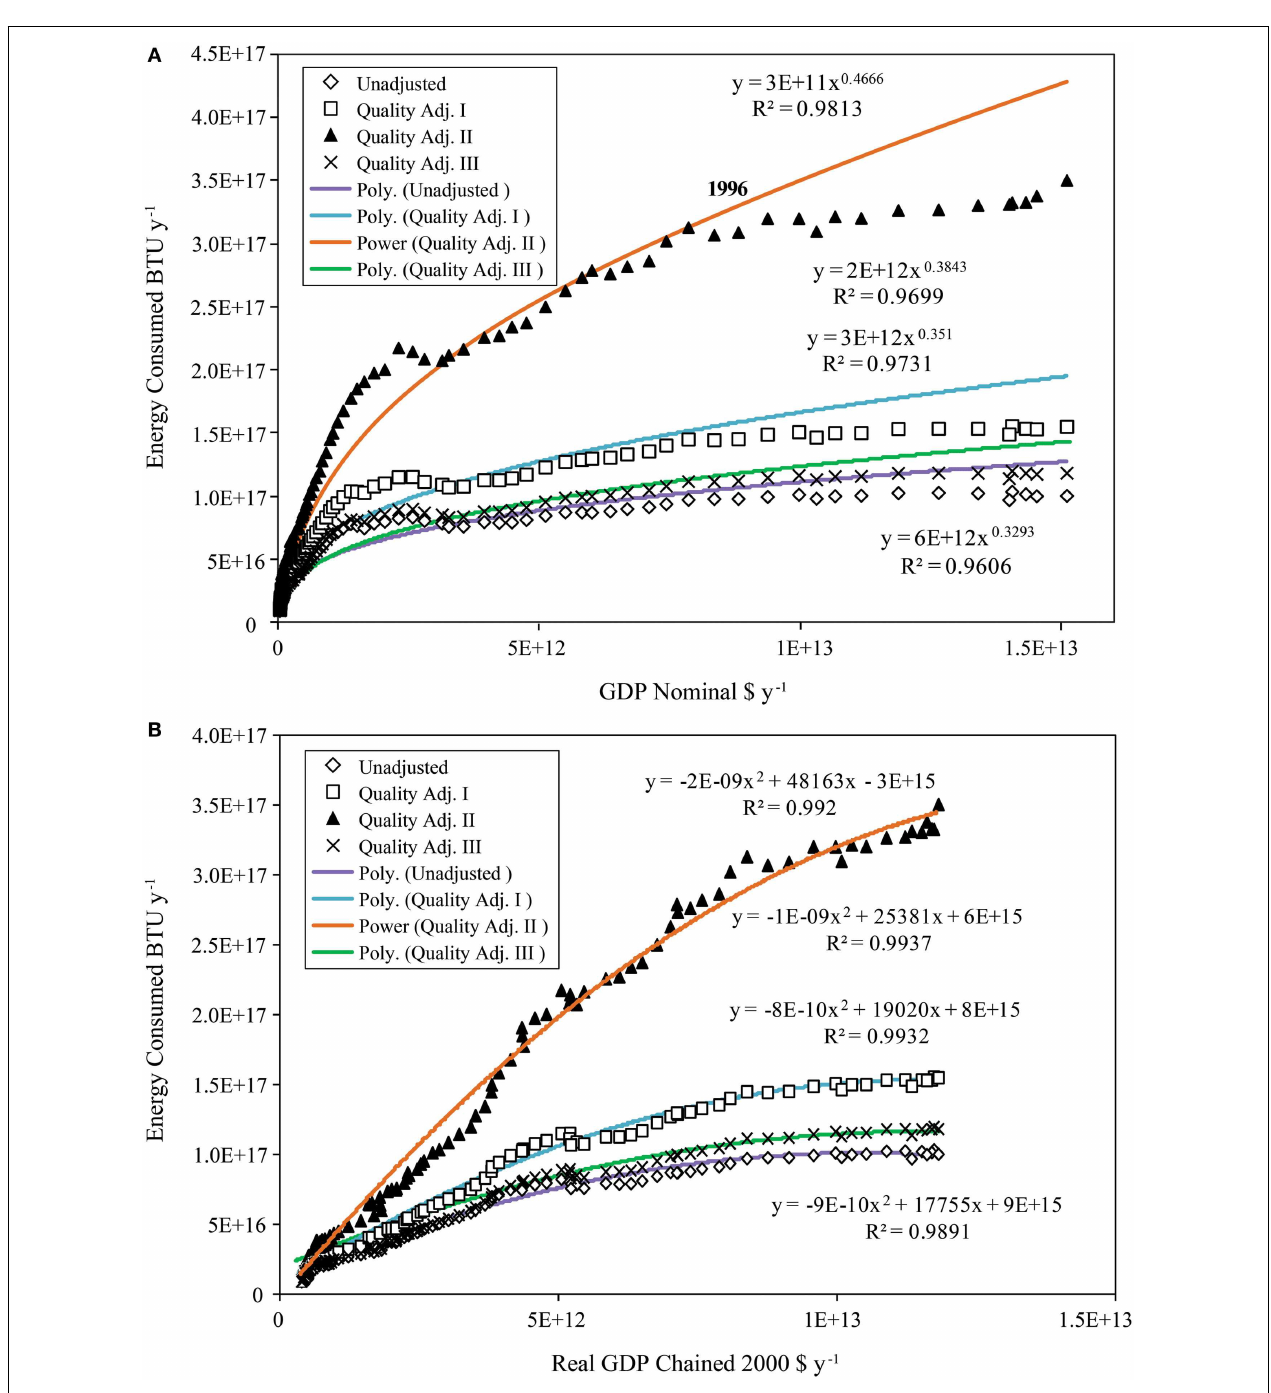
FIGURE 12 | Measures of energy consumption as functions of nominal and real GDP are shown . (A) After 1996, energy consumption and QA energy consumption depart from a power law relationship as a function of nominal GDP; (B) energy and QA energy consumption are best fit by a second order polynomial as a function of real